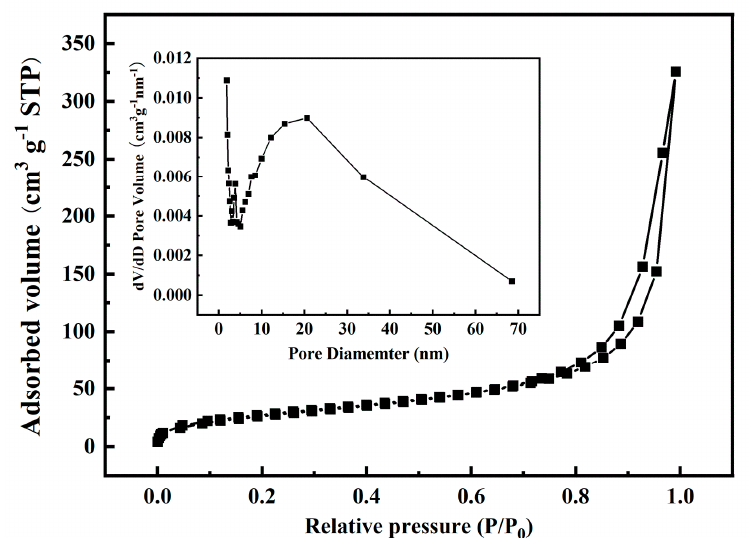
Figure 4. N 2 adsorption-desorption isotherm diagram of GO − CE − CS − PVA.